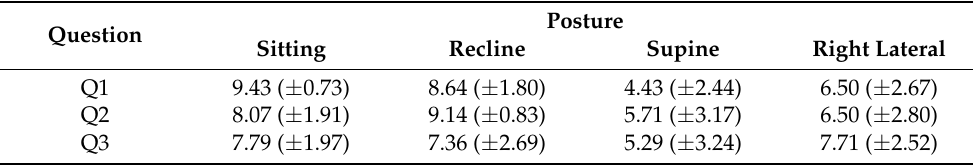
Table 2. The averaged response score over subjects for each question in each posture (mean ± standard